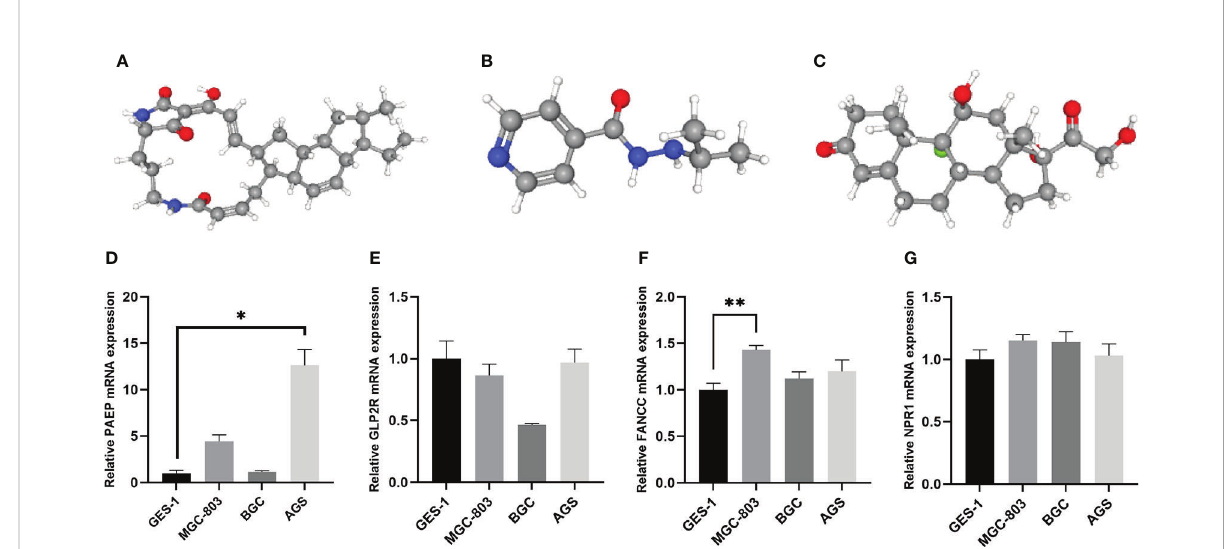
FIGURE 14 The 3D structure of the three small molecule drugs for GC and validation of the expression levels of the prognostic m 6 AIGs in cell lines. (A) Ikarugamycin. (B) Iproniazid. (C) Fludrocortisone. (D – G) The expression offour mRNAs from m 6 AIGs-PS in GC cells and GES-1. * p < 0.05, ** p <